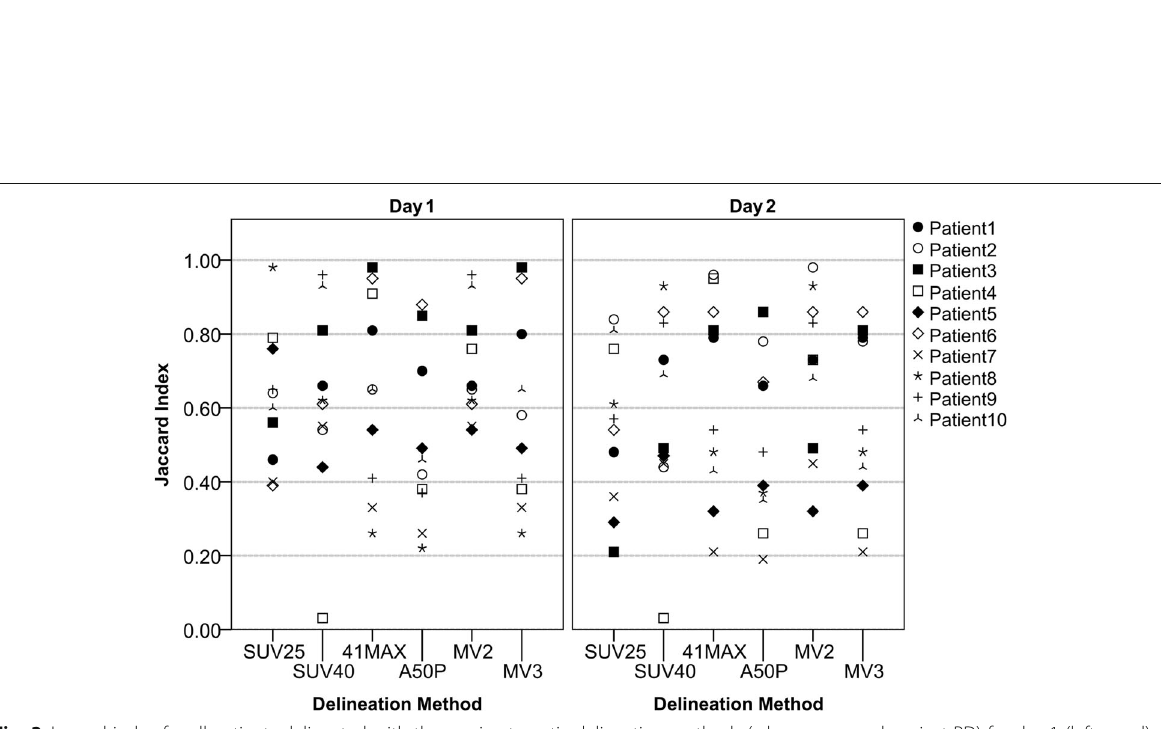
Fig. 3 Jaccard index for all patients delineated with the semi-automatic delineation methods (when compared against RD) for day 1 (left panel) and day 2 (right panel). Each patient is displayed with a different